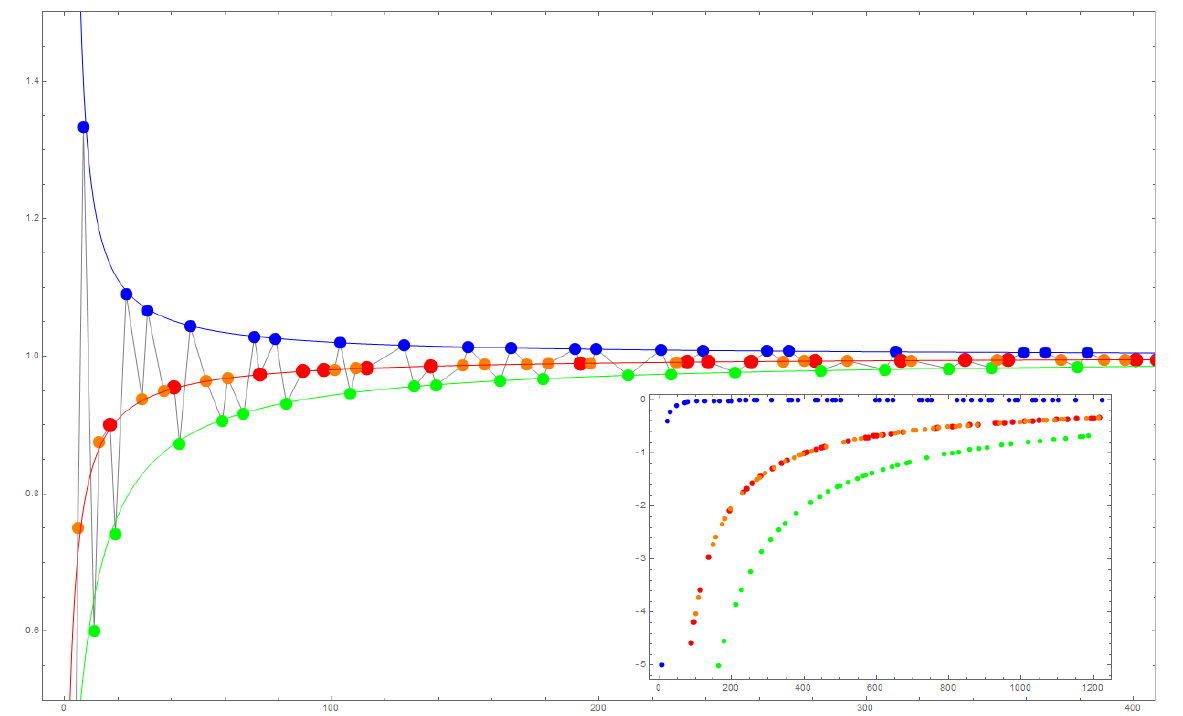
Figure 5. Plot of R (ordinate) for m = p primes for 5 to 1223 (abscissa). The color represents set of primes of the form 8 n + 1 (red), 8 n + 3 (green), 8 n + 5 (orange), and 8 n + 7 (blue). Inset: a blow-up of the ordinate. The colored curves are the functions R = p (blue). Inset: The relative percent error of the model function compared to the